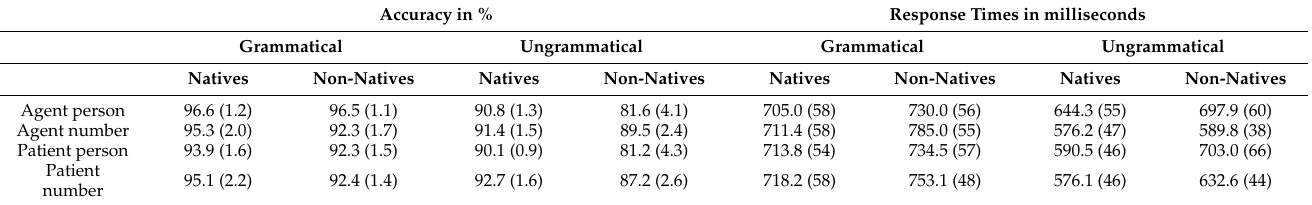
Table 3. Percentage of correct responses (%) and mean reaction times (ms) (SDE in parentheses). Accuracy in % Response Times in